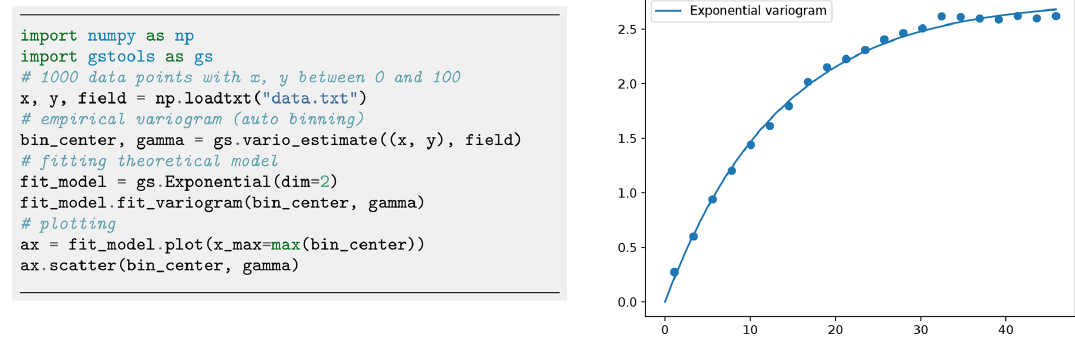
Figure 5. Estimating an empirical variogram of synthetic unstructured data and fitting an exponential model. The number of bins was calculated to be 21 with a maximum bin distance of ca.